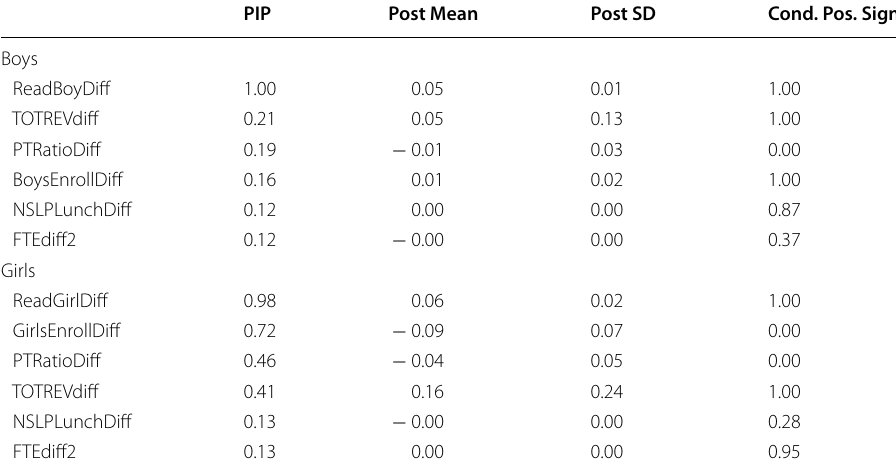
PIP: Posterior inclusion probability; Post Mean: expected a posteriori estimate; Cond.Pos.Sign: Probability that the sign of the estimate is positive conditional on inclusion in the model